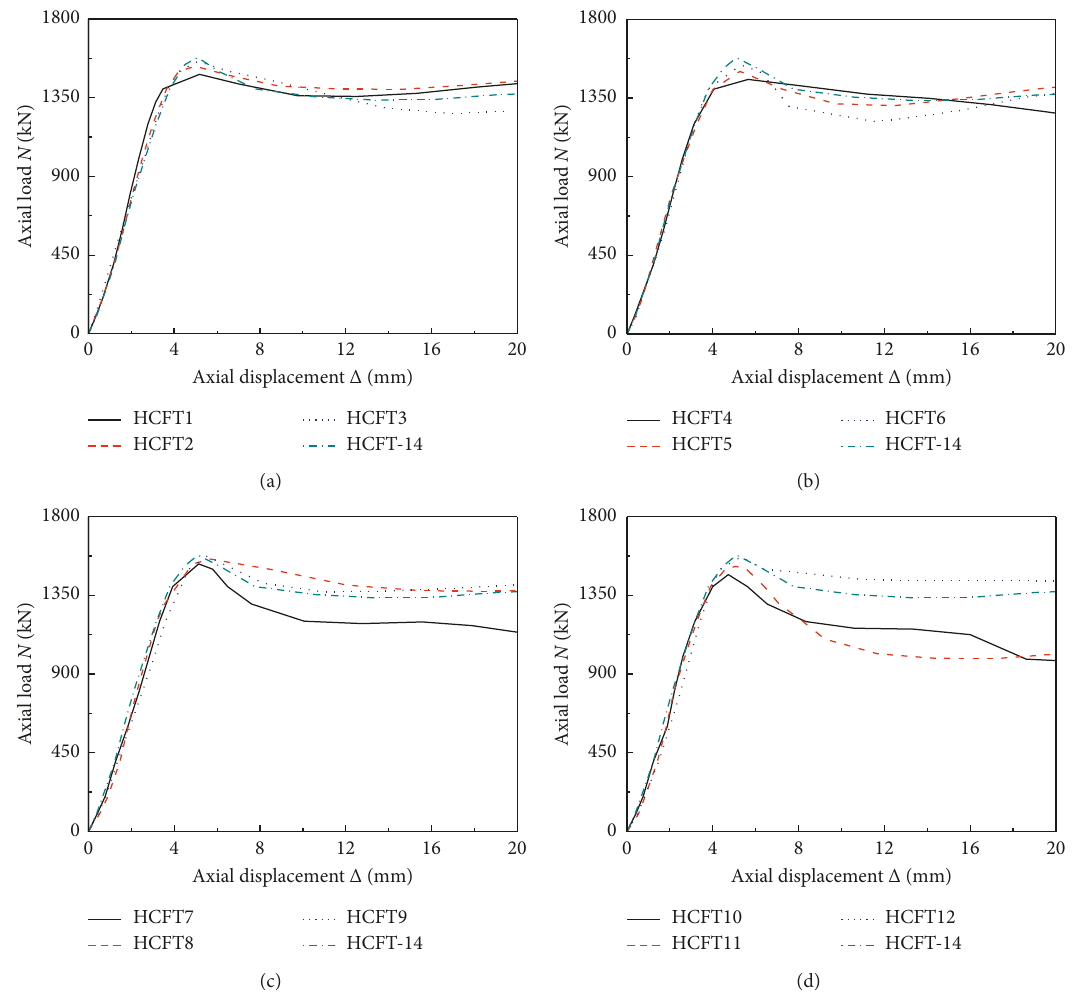
Figure 6: Load-displacement curve of hexagonal CFST columns. (a) HCFT1 ∼ HCFT3. (b) HCFT4 ∼ HCFT6. (c) HCFT1 ∼ HCFT3. (d) HCFT4 ∼